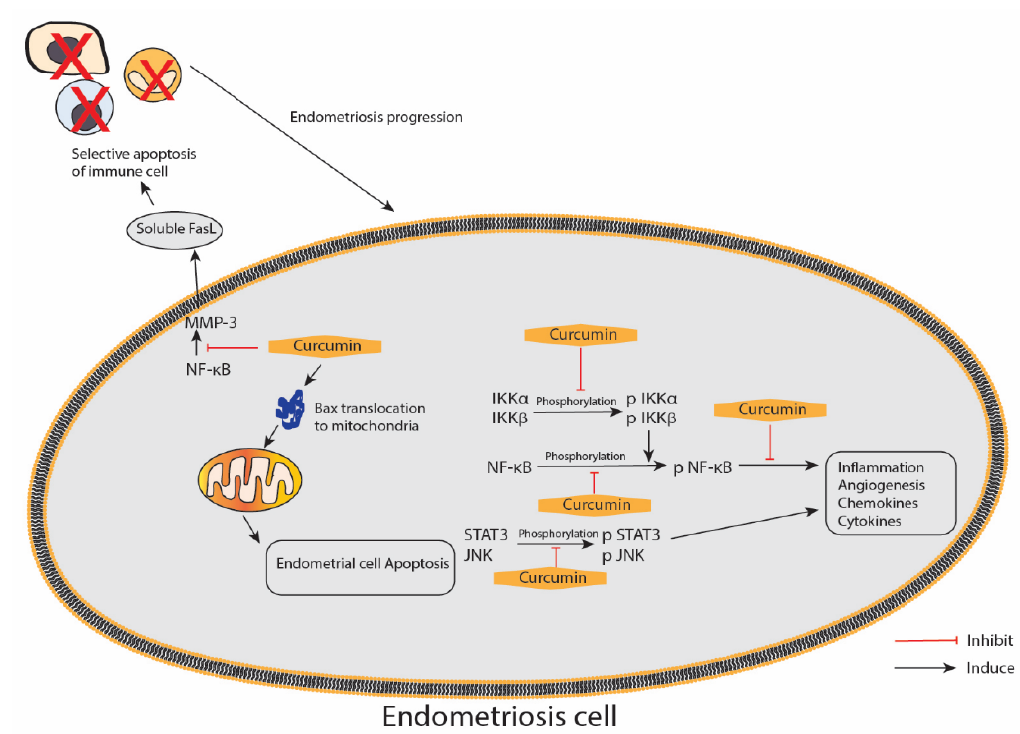
Figure 5. An illustration of the proposed curcumin effect on the inflammatory and apoptotic pathways in endometriosis. IKKα/β—inhibitor of nuclear factor κ - B kinase subunit α/β; JNK— c-Jun N-terminal kinases; NF- κB—nuclear factor κ - light-chain-enhancer of activated B; STAT3 — signal transducer and activator of transcription 3; p — phosphorylated form; MMP-3 — matrix metalloproteinase 3; FasL — Fas ligands; arrow represents a promotion, and blunt arrow represents inhibition.